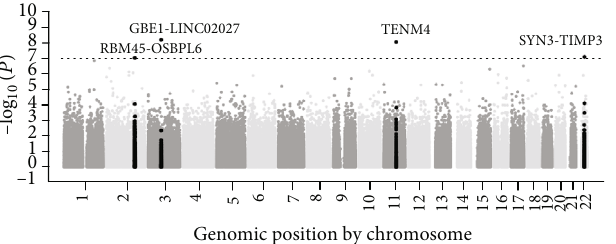
Figure 1: Pooled DNA-based GWAS results for ITP. The Manhattan plot of the GWAS shows the P value for the 862,620 autosomal SNPs. SNPs are plotted on the x -axis according to their position on each chromosome, and the negative log-10 of the P value was plotted on the y -axis. The horizontal dotted line indicates a P = 1 : 0 × 10 − 7 , which is the criteria of selecting SNPs for GWAS.